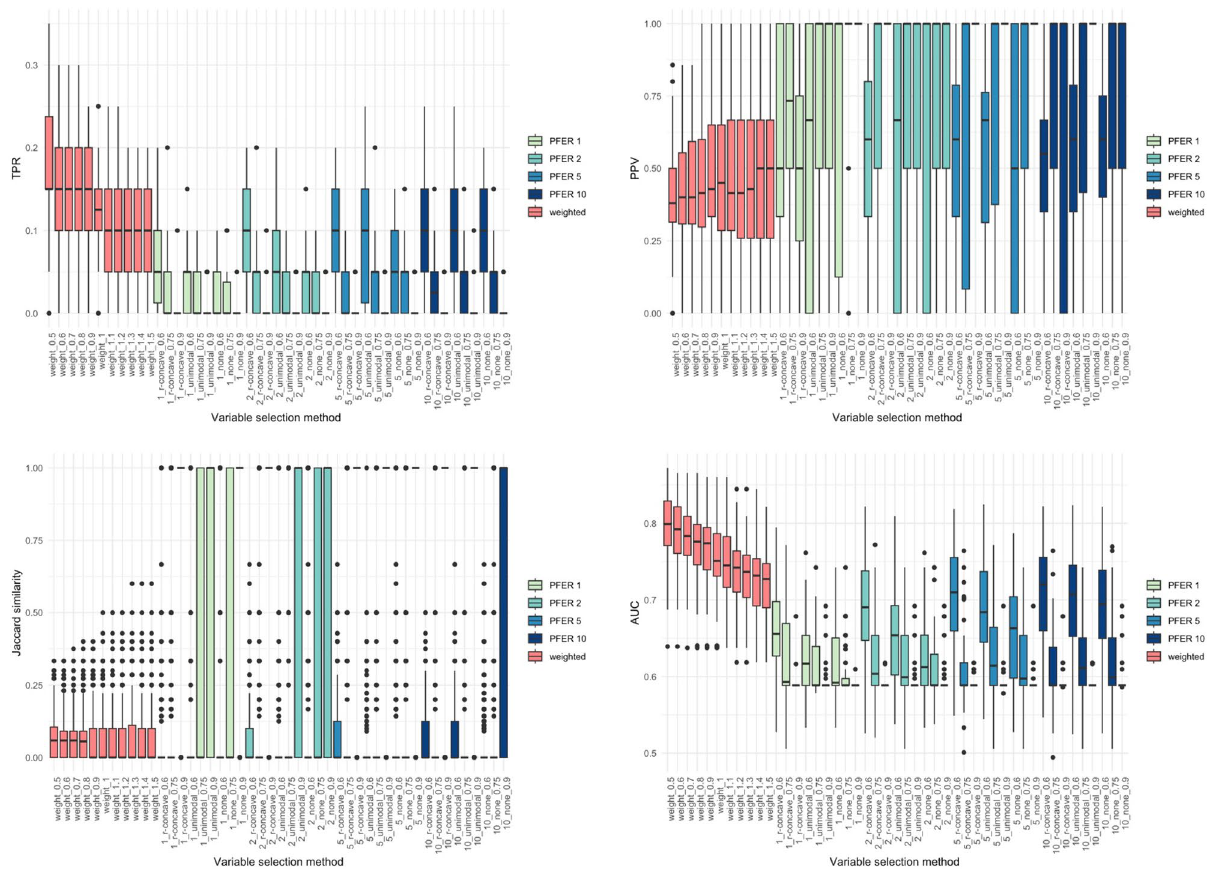
Figure 5. Box plots of true positive rate (TPR), positive predictive value (PPV), stability index (Jaccard similarity coefficient) and the area under the receiver operating characteristic curve (AUC) of the weighted